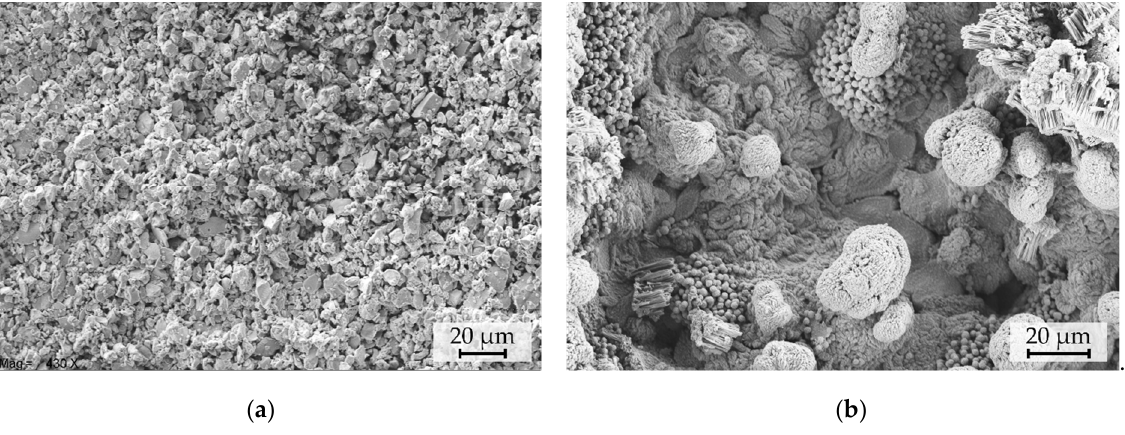
Figure 12. Top-view SEM micrographs of NdFeB5 micromagnets ( a ) after 50-day immersion test and ( b ) 96-h PCT.